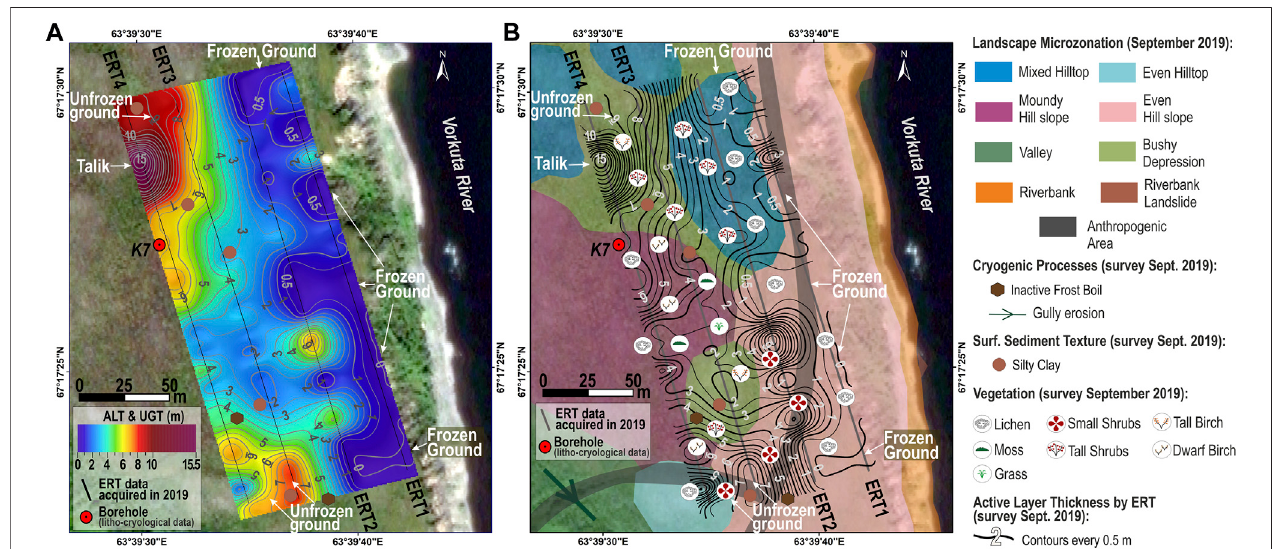
FIGURE 9 | (A) ALT and UGT map (contours every 0.5 m) performed from the interpretation of the ERT1, ERT2, ERT3, and ERT4 pro fi les acquired in Site 1A, superimposed on the satellite image. The map highlights agradual decrease in ALT bymoving eastward to the Vorkuta River; the ALT ranges from 0 m (dark blue) in the eastern side of the map to about 7 m (red) in the NW part. ALT values greater than 7 m represent unfrozen ground areas not underlined by permafrost or an area occupiedbyatalik.Thetalik,locatedinthenorth-westernsideofERT4,exhibitsanunfrozengroundthicknessuptoabout16 m(highlightedinpurple).Theposition of borehole K7 is indicated (red circle). Surface lithology information collected during the geocryological survey is also shown, evidencing that silty clay deposits (brown dots) represent the major soil texture type. (B) ALT isolines (every 0.5 m) superimposed to the landscape microzonation, morphological and cryogenic processes, and vegetation type (2019 fi eld survey). The hilltops are characterized by frozen ground, the hillslopes are characterized by frozen ground to thin/large ALT (1 – 7 m), and depressions are marked by thick unfrozen ground (7 – 9 m) or a talik area (9 – 16 m thick thaw soil in the NW of the map). Local inactive frost boils (dark brown hexagons) arelocatedincorrespondenceofa4 – 5 mALT,withinevenhillslopeandbushydepression microzonetypes. Theanthropogeniczone(darkgray area)correspondshere to unpaved pathways. Maps compiled using ArcGis ® (Esri) software. Datum: WGS84; projection: UTM 41N. Satellite base image (Gis layer “ World Imagery ” ) retrieved in 2019 from the ArcGis online database